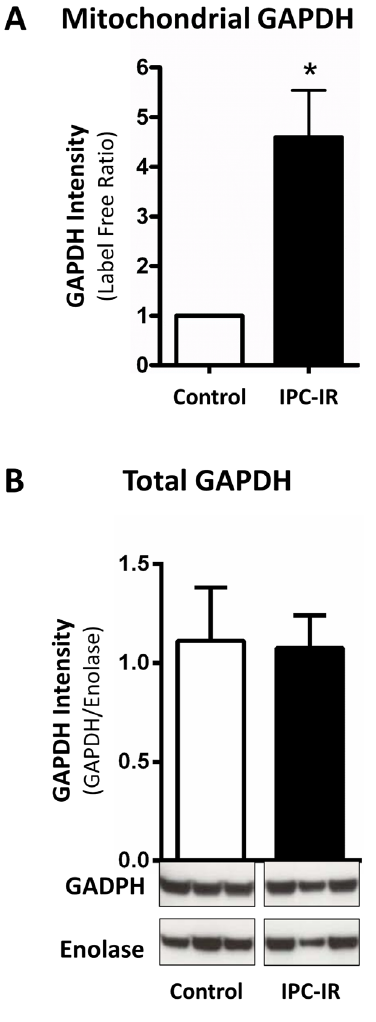
Figure 2. Mitochondrial GAPDH and total GAPDH levels following cardioprotection. ( A ) GAPDH protein levels in the mitochondrial fraction of hearts subjected to control or an IPC-I/R protocol were assessed via liquid chromatography-tandem mass spectrometry, followed by label-free peptide quantification (*p , 0.05 vs. control, n=3). ( B ) Total GAPDH protein levels in hearts subjected to control or an IPC-I/R protocol were assessed via western blot analysis. Representative western blots are shown for total GAPDH (upper) and enolase (lower) in whole heart homogenates together with the densitometry of GAPDH normalized to enolase (n=3).